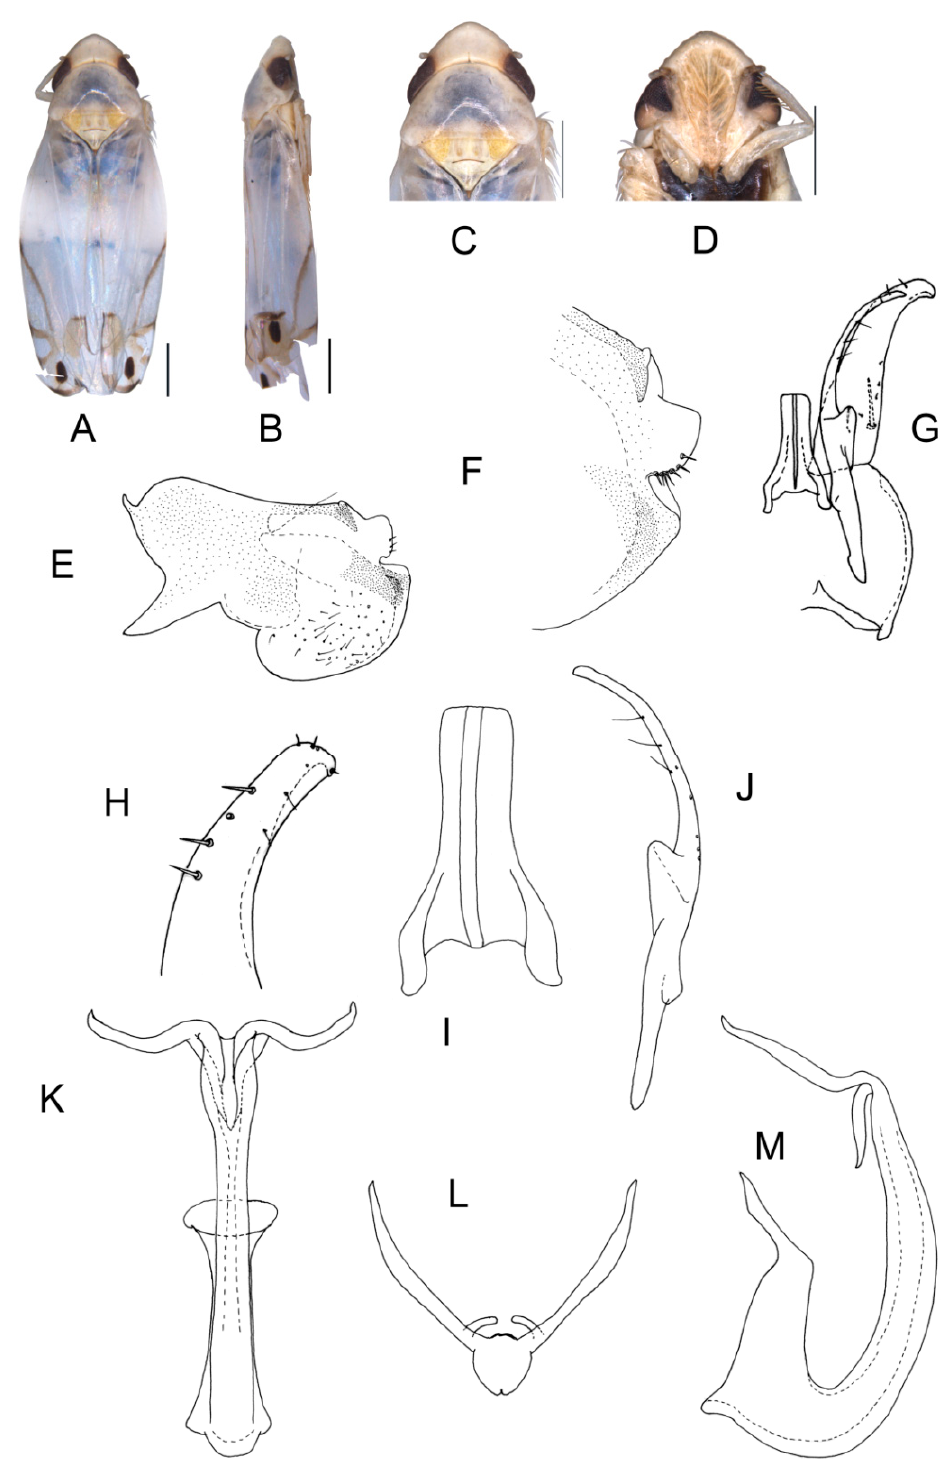
Figure 2. Eurhadina ( Singhardina ) galacta sp. nov. : ( A ) habitus, dorsal view; ( B ) habitus, lateral view; ( C ) head and thorax, dorsal view; ( D ) face; ( E ) male pygofer side, lateral view; ( F ) hind part of pygofer, lateral view; ( G ) subgenital plate, connective, paramere and sternite IX, dorsal view; ( H ) apex of subgenital plate, dorsal view; ( I ) connective, dorsal view; ( J ) paramere, dorsal view; ( K ) aedeagus, posterior view; ( L ) apex of aedeagal shaft, dorsal view; and ( M ) aedeagus, lateral view. Scale bars: 0.5 mm.